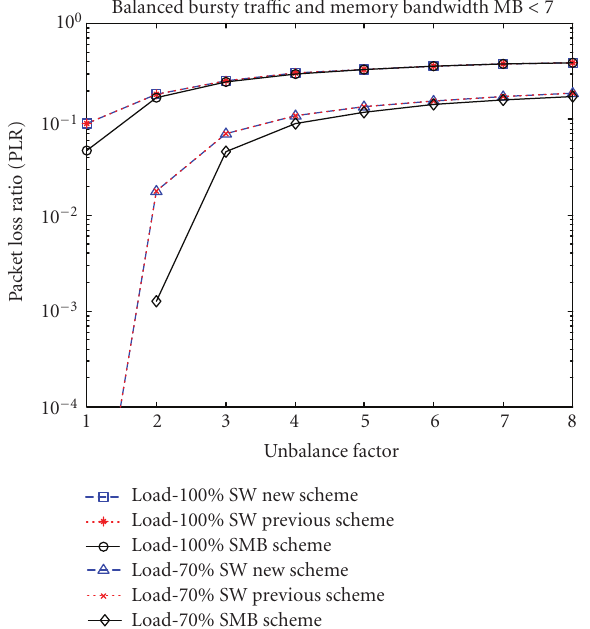
Figure 11: Average memory-bandwidth requirements of SW and SMB